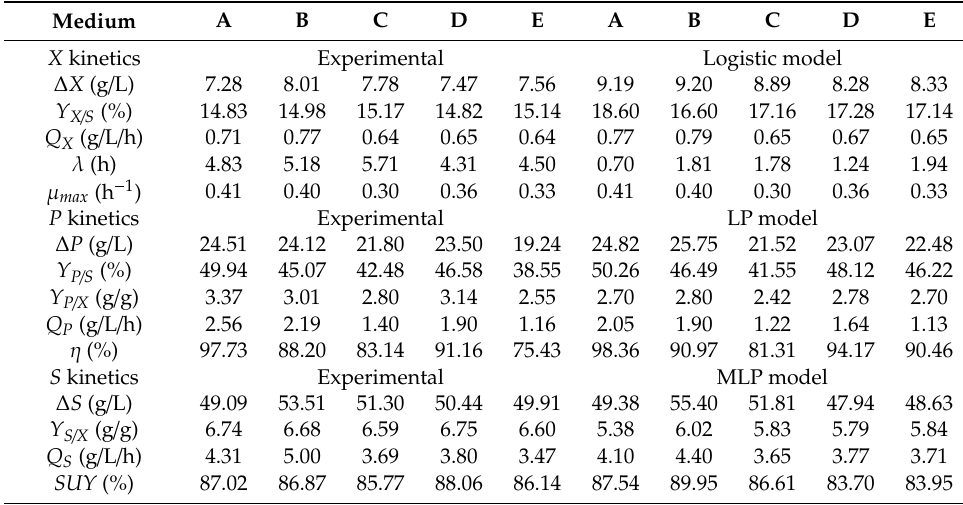
Table 2. The calculated kinetics from the experimental and the predicted data related to cell growth, ethanol production and substrate